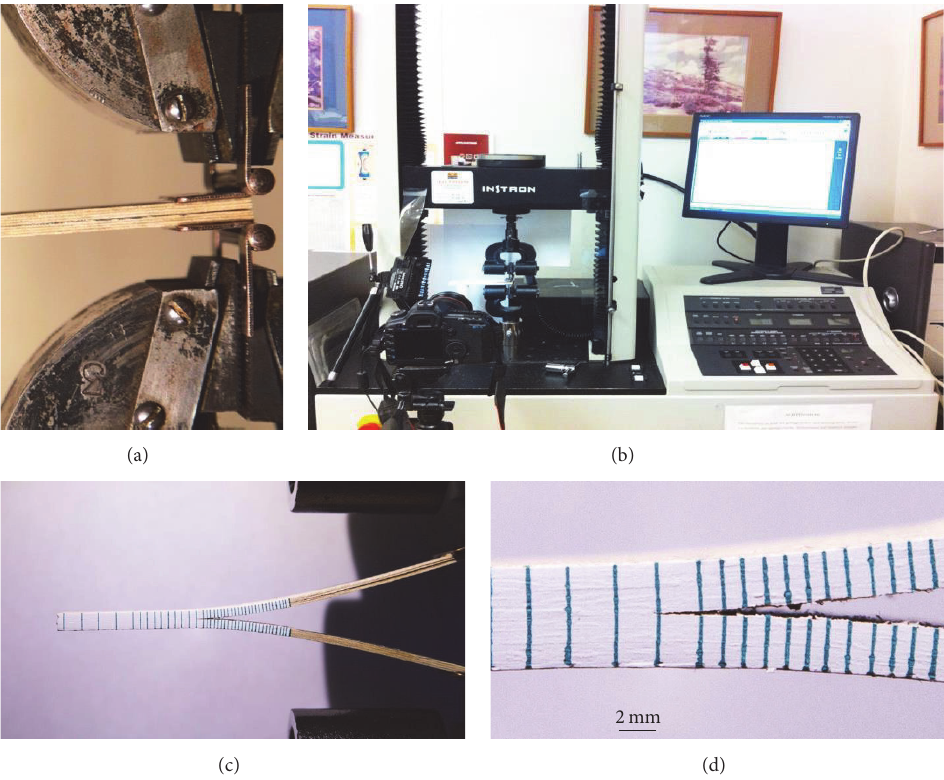
Figure 2: Mode I (crack opening mode) fracture toughness testing of a laminated birch wood composite: (a) Hinges used to attach one end of a specimen to the two cross-heads; (b) universal tensile testing machine with attached computer, and also showing the position of the DSLR camera for measurement of crack propagation and crack length; (c) white coated edge of one side of a specimen with scale markers; (d) higher magnification image of (c) showing the position of a crack tip